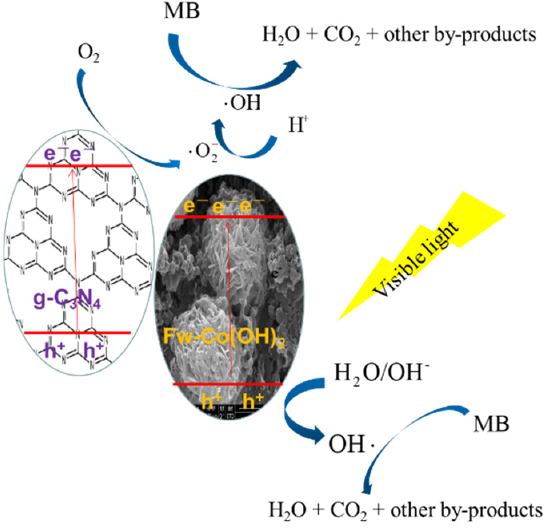
Figure 9. Schematic illustration of a possible mechanism of Fw-Co (OH) 2/ g-C 3 N 4 in MB photocata- lytic degradation.